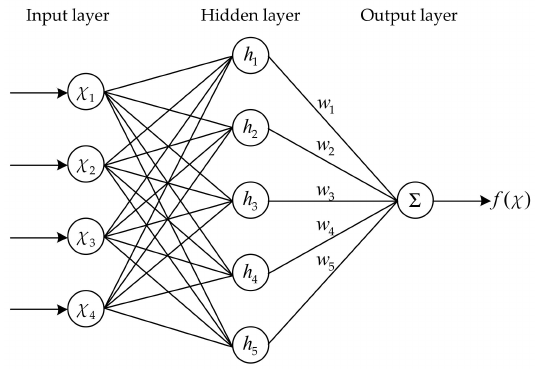
Figure 8. Schematic diagram of the RBFNN